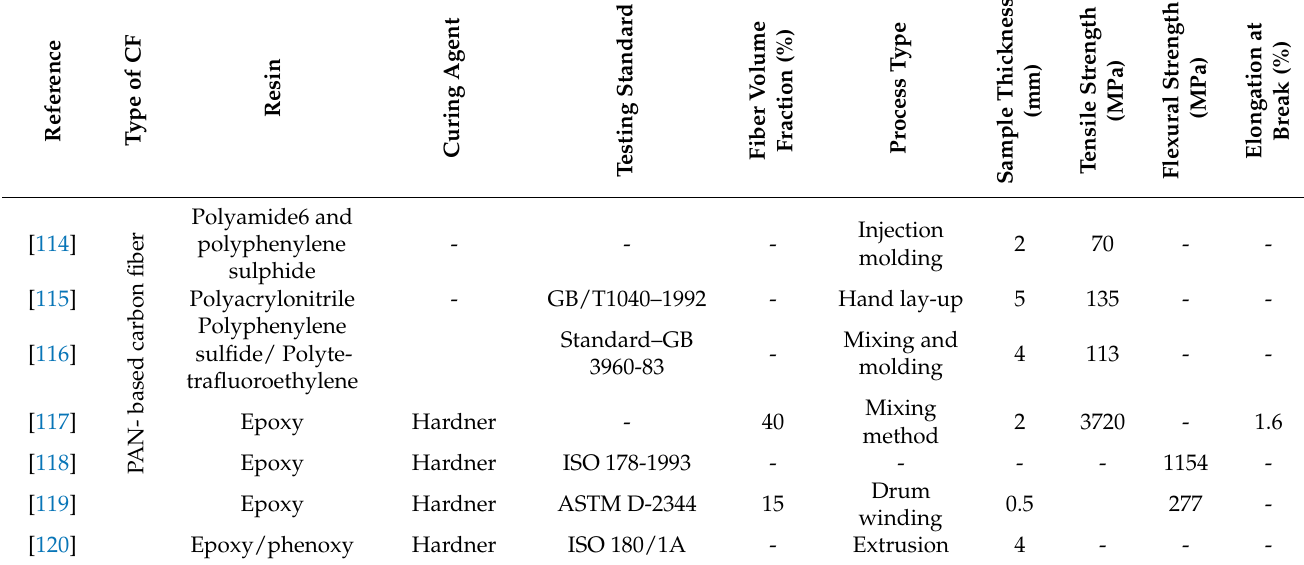
Table 5. Main mechanical properties of CFRP composites according to different types of reinforcements and matrix.